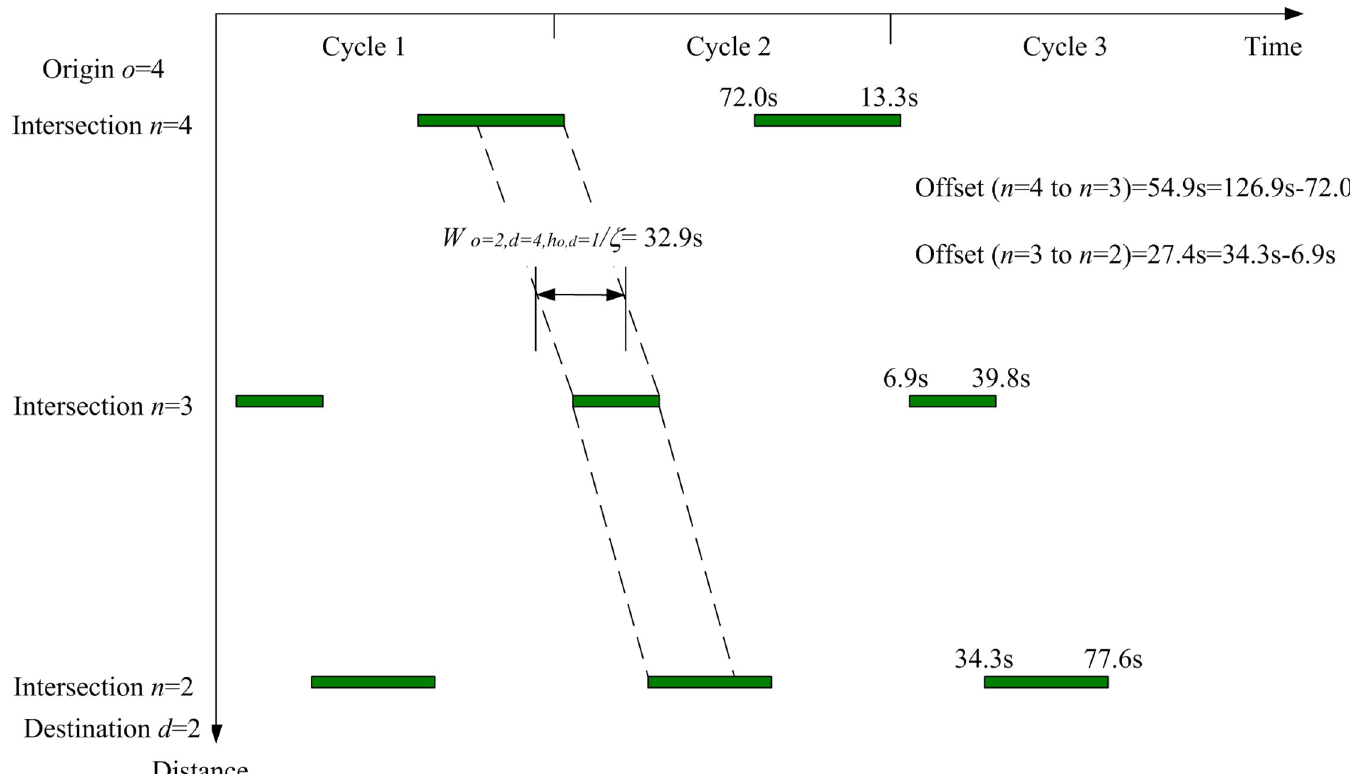
Fig 10. Time-space diagram from origin o = 4 at intersection n = 4 to destination d = 2 at intersection n = 2.